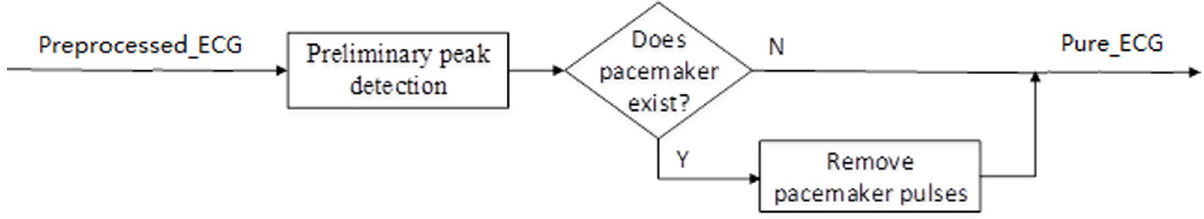
Fig 6. Flowchart for removing the pacemaker pulse.